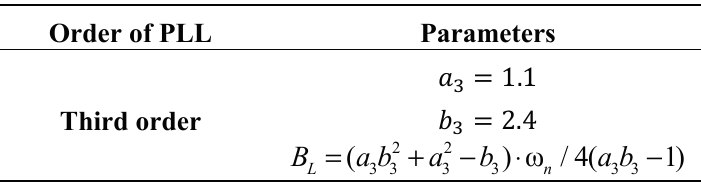
Table 4. Simulation parameters of PLL.